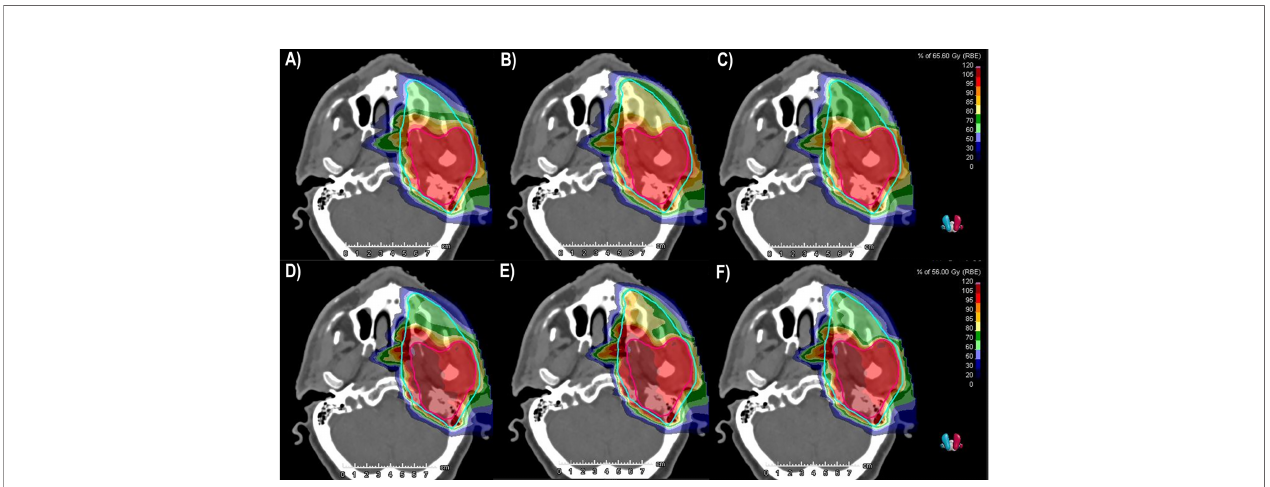
FIGURE 1 | LEM and mMKM dose distributions calculated for patient P6. The top (bottom) panel corresponds to LEM (mMKM) doses: (A, D) SEQ approach. (B, E) SIB 54.4 . (C, F) SIB 48.0 . The HR-CTV and LR-CTV are delineated in purple and light blue, respectively. The isodoses were normalized to the HR-CTV prescriptions. LEM, local effect model; mMKM, modi fi ed microdosimetric kinetic model; SEQ, sequential boost; SIB, simultaneous integrated boost; HR-CTV, high-risk clinical target volume; LR-CTV, low-risk clinical target volume.